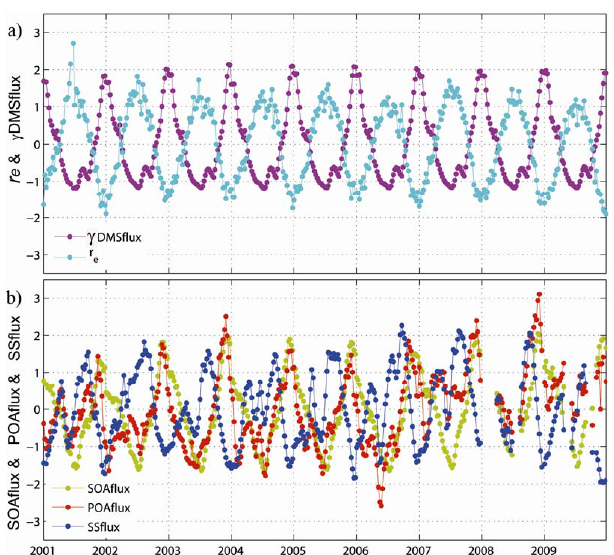
Figure 2 Fig. 2. Temporal evolution (2001–2009) of standardized values of (a) weekly satellite-derived r e and γ DMSflux; (b) weekly SOA flux, POA flux and SSflux averaged over the entire Southern Ocean (40–60 ◦ S). Correlation coefficients are presented in Table